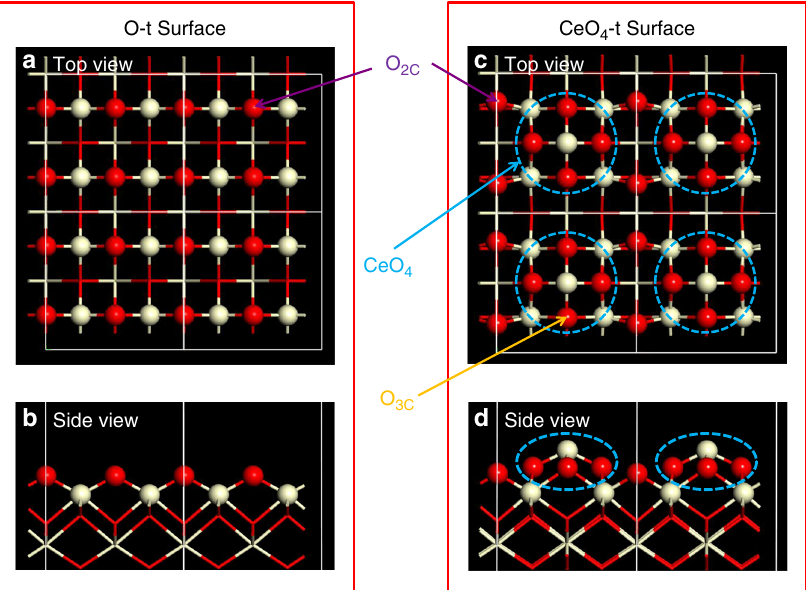
Fig. 3 Structure of O-t and CeO 4 -t surface. Surface oxygen ions are represented as red balls and cerium ions as off-white, in the top and side views of ceria (100) facets with an O-t surface ( a , b ) and a CeO 4 -t surface ( c , d ). The top views ( a , c ) each show four surface units (each surface unit is 7.7 Å × 7.7 Å = 59.3 Å 2 ), delimited by white boxes. Each O-t surface unit includes four O 2C ions, while each CeO 4 -t surface unit contains two O 2C ions and one CeO 4 reconstruction (blue dashed circle), with four three-coordinated oxygen ions (O 3C